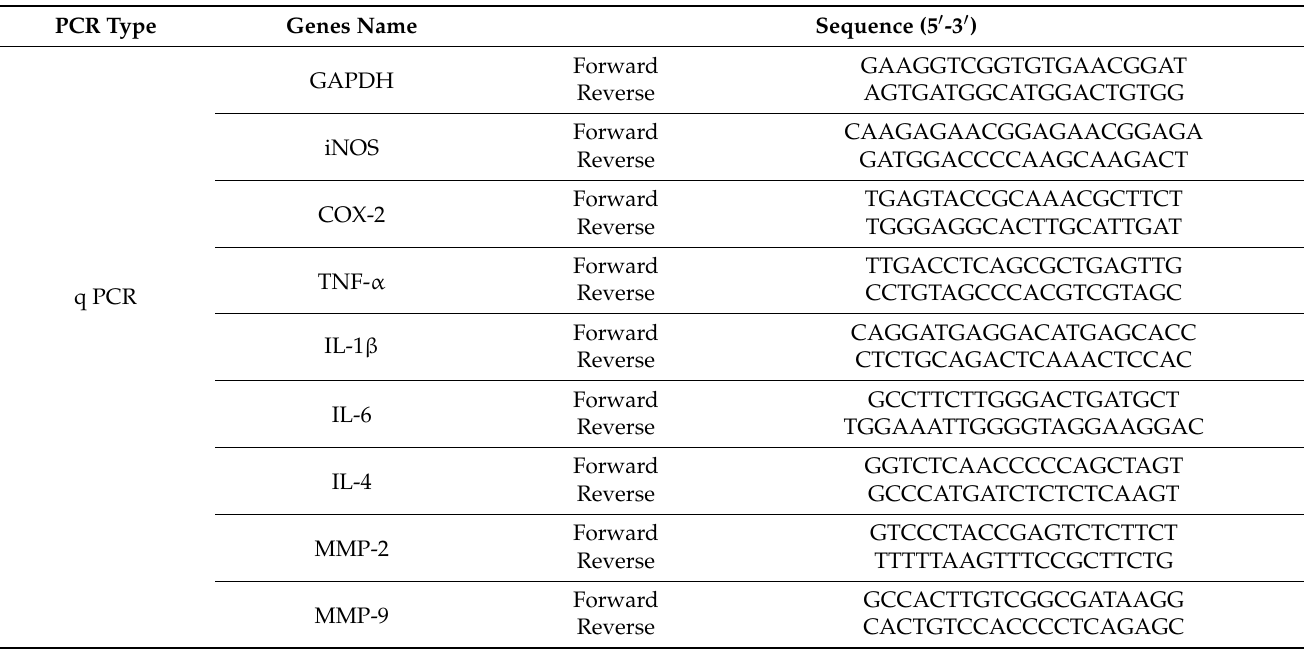
Table 1. Primer sequences used for quantitative real-time